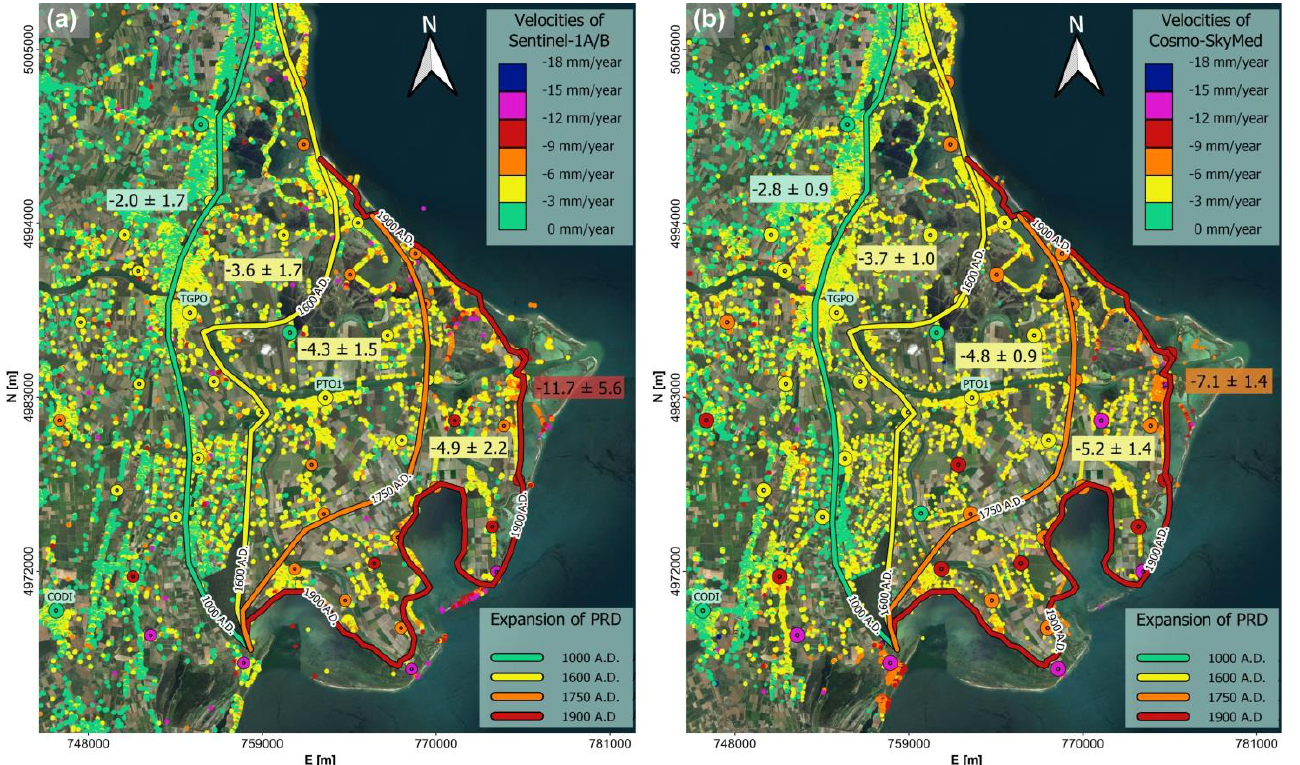
Figure 10. Distribution of the LOS velocities in the study area overlapped to the highstand PRD lobe map (modified from [55]). For each sector enclosed by the polylines that highlight the expansion of the PRD over time, the LOS velocities and the related standard deviations were obtained by averaging the values of the available points. ( a ) GNSS and Sentinel-1 points; ( b ) GNSS and CSK points. Finally, the obtained LOS kinematic pattern, both for GNSS-Sentinel-1 and GNSS- CSK data, were interpolated over the whole study area following a strategy similar to that proposed by Tosi et al. [36]: (i) overlapping the InSAR data (both for Sentinel-1 and CSK) and the GNSS points (both continuous and NPS) on a common map; (ii)